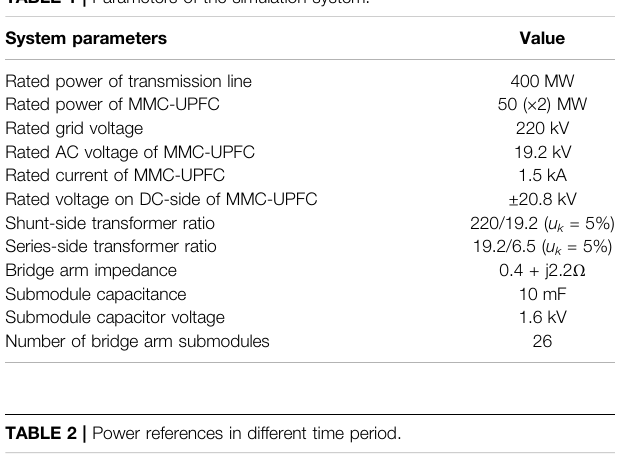
TABLE 1 | Parameters of the simulation system.